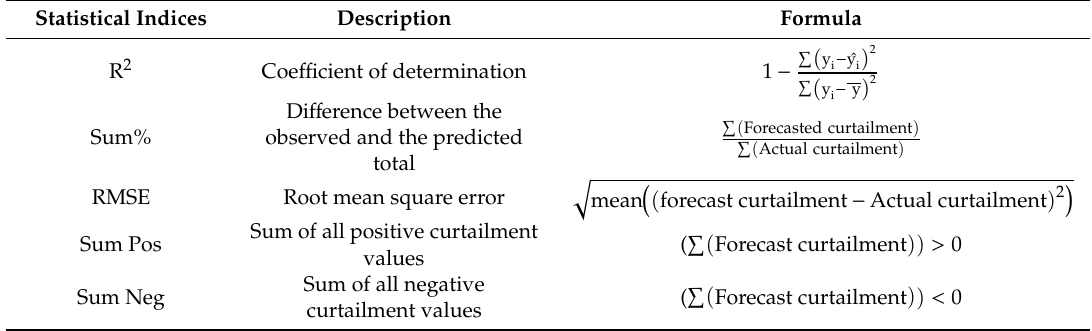
Table 4. Statistical indices description and formula.